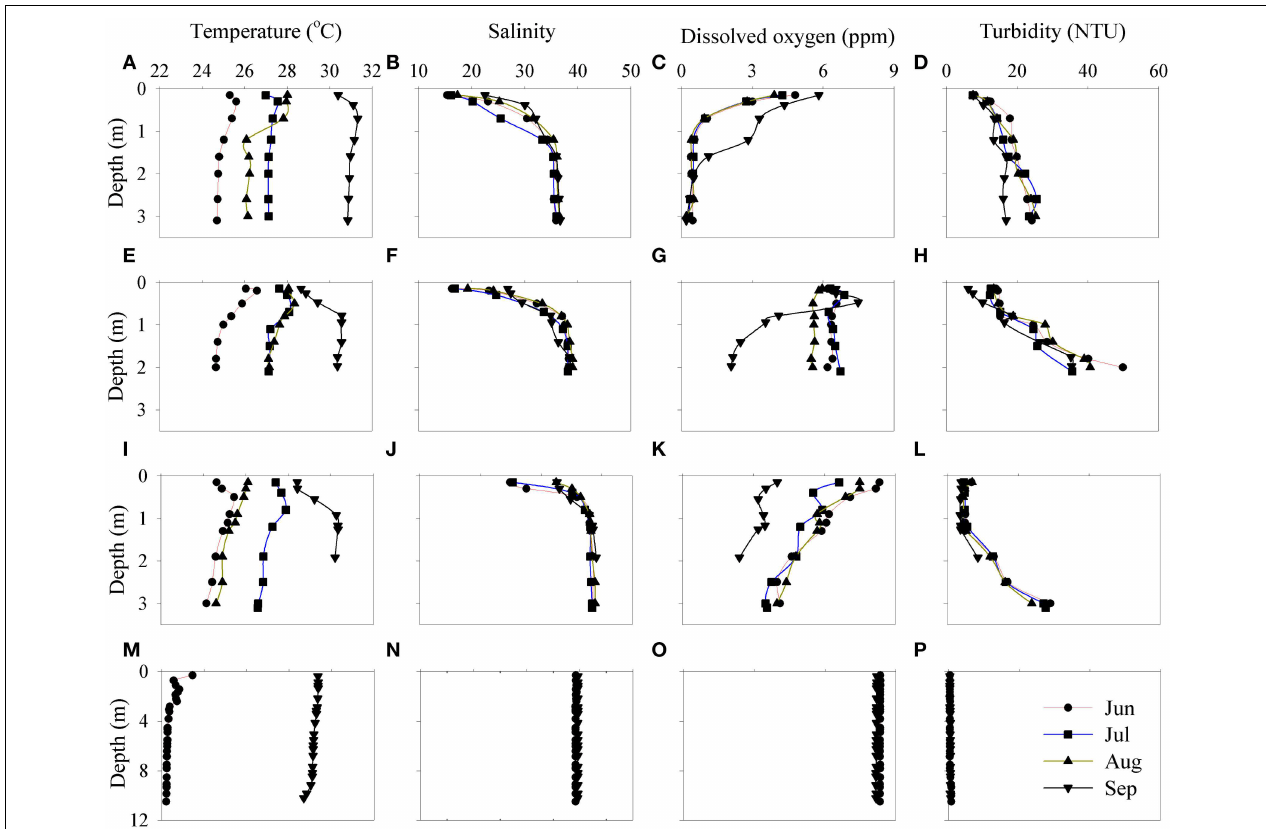
FIGURE 2 | Physicochemical depth profiles of the Qishon estuary stations downstream toward the coastal reference station; E3 (Histadrut)—(A–D), E1 (Maagan)—(E–H), E2 (Yulius)—(I–L), and Sh- (M–P). Measurements were taken between June and